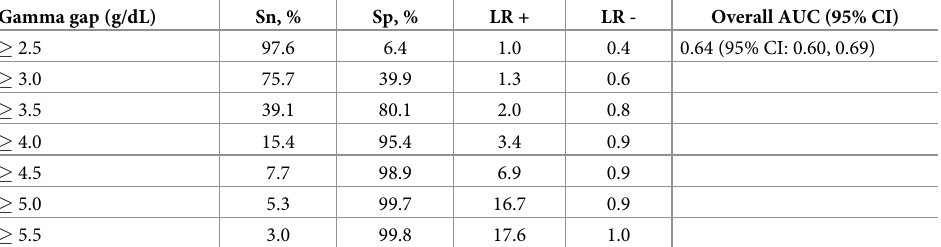
Table 4. Diagnostic performance of gamma gap for MGUS using different gamma gap thresholds, N =